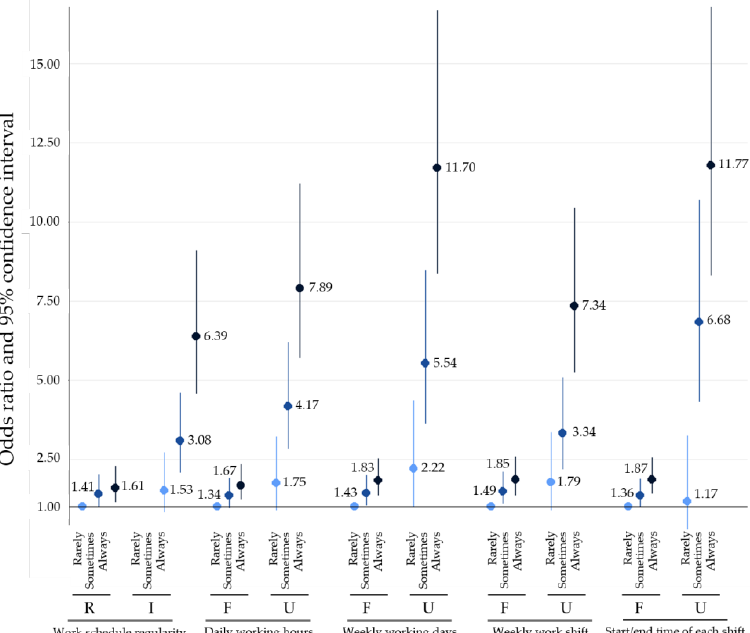
Figure 2. Odds ratios and 95% confidence intervals for severe sleep disturbance according to work schedule regularity and frequency of emotion suppression at work. “R” stands for regular and “I” stands for irregular. “F” stands for fixed and “U” stands for unfixed. Regular work schedule indicates a schedule with fixed daily working hours, weekly working days, weekly work shift, and start and end time of each shift.